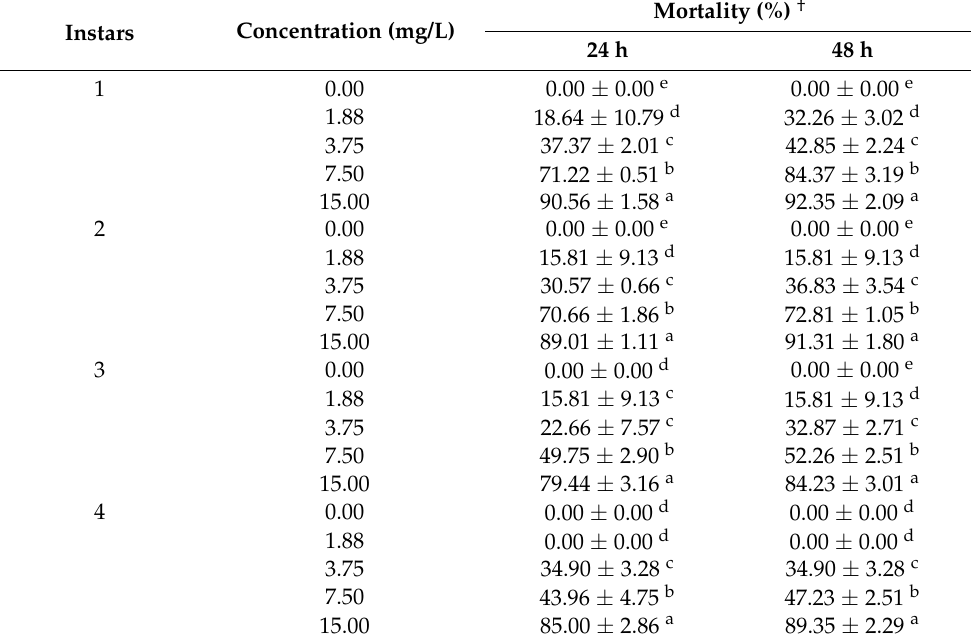
Table 2. Effects of different concentrations of Kathon on the mortality of larvae of A. albopictus in each